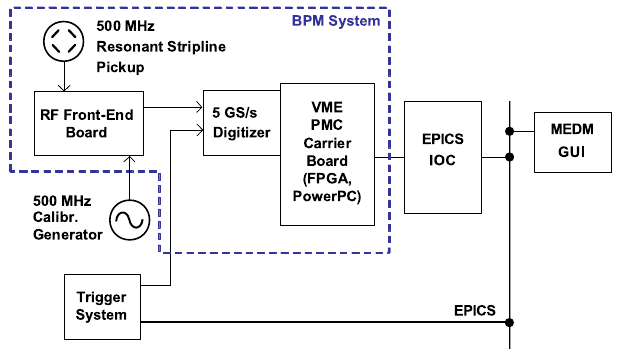
FIG. 31. BPM system block schematics, including the linkage to the external trigger system and the EPICS control system (see Sec. IV G)